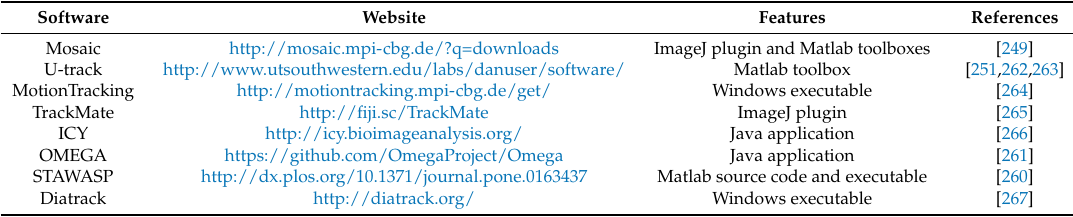
Table 3. Open source tracking and trajectory analysis packages. Adapted from [253,261].